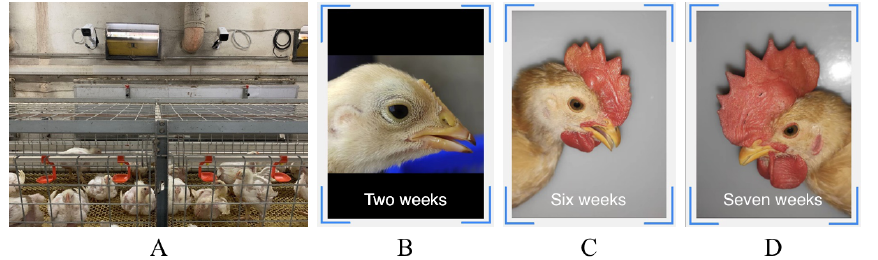
Figure 9. Application scenarios based on the methods in this paper. ( A ) is the deployment site; ( B – D ) are screenshots of the